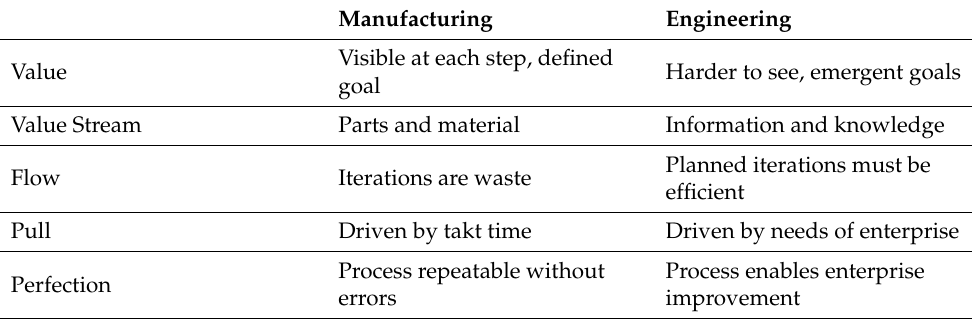
Table 1. Lean Principles in Manufacturing vs. NPI